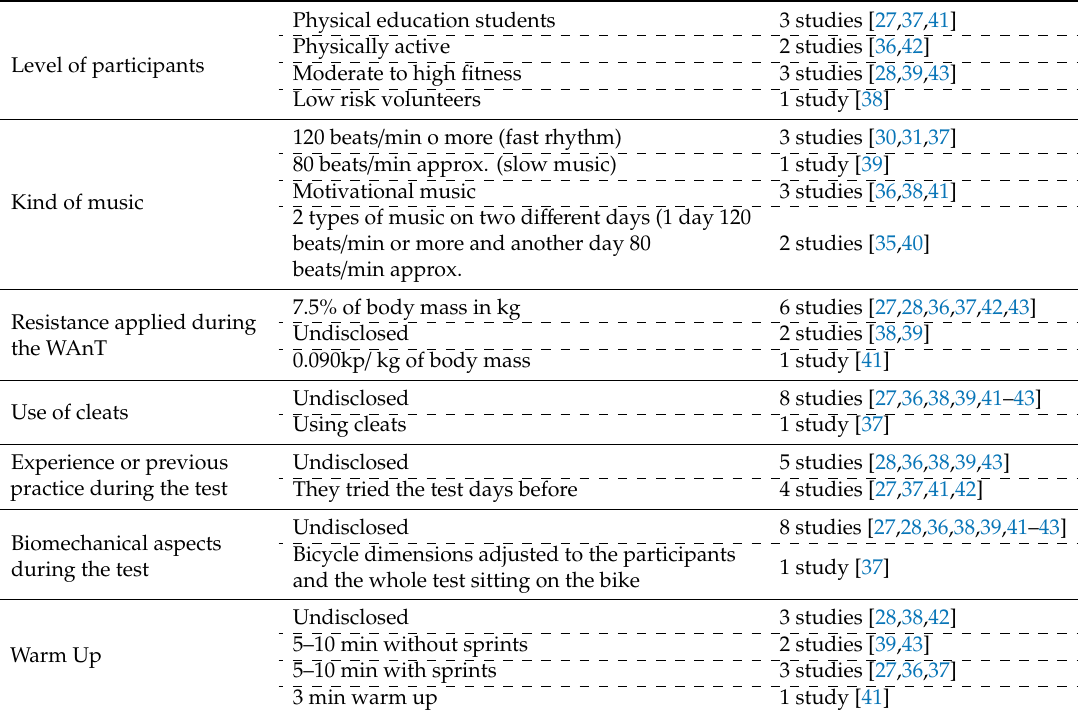
Table 3. Studies included in the systematic review: features of those taking part and of the relevant